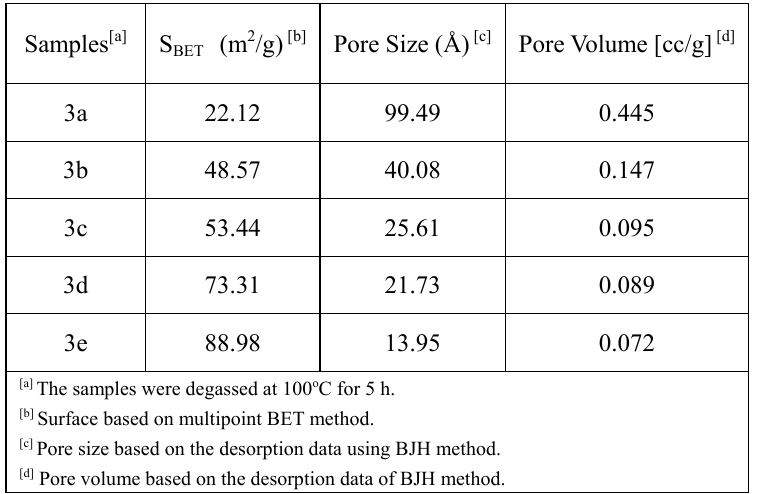
Table 1. The surface area, pore diameter and pore volume of 3a-e